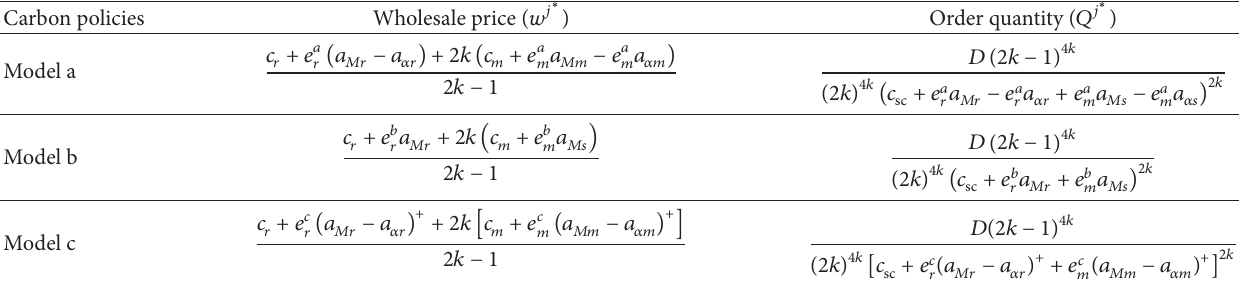
Table 1: The optimal decisions for the three models under symmetric